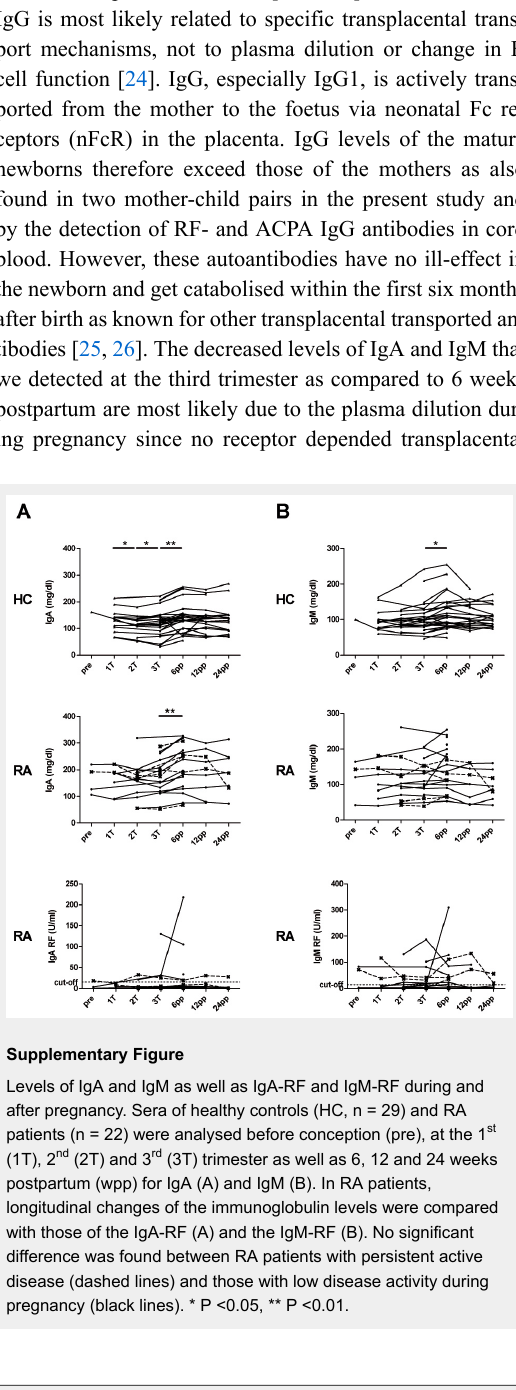
Table 2: RF, ACPA and immunoglobulin levels in two mother-child pairs. Mother-child